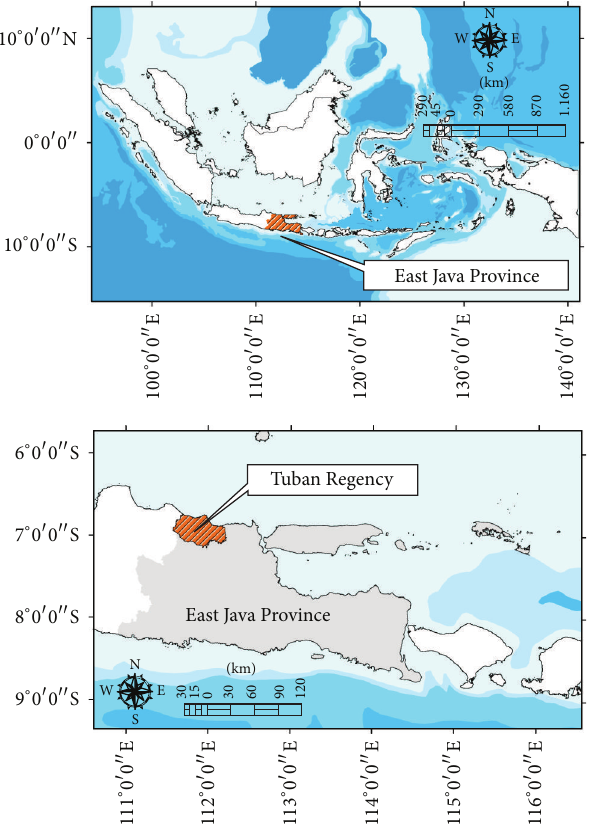
Figure 1: Study area of Tuban Regency, East